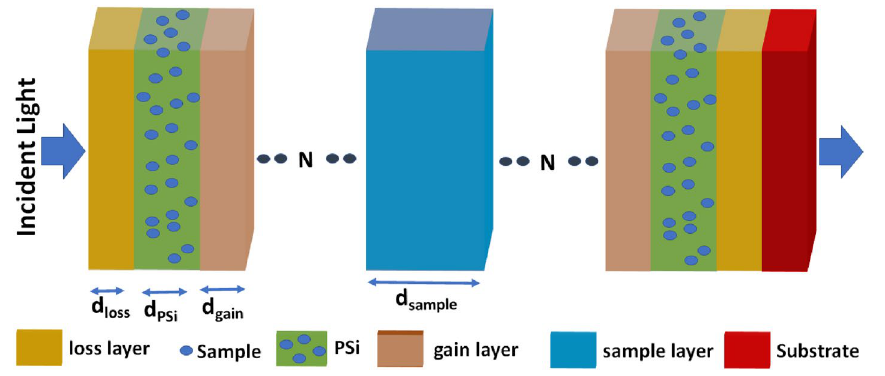
Figure 1. The configuration of the proposed